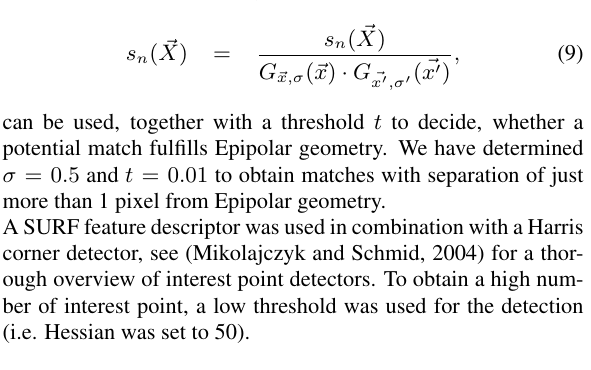
Table 1: Reconstruction Statistics for Different Camera Sys- tems: The table lists the results of reconstruction. Errors of > 100 mm were considered false matches. Displayed are me- dian errors (mm), which gives a good indication of the overall performance. Numbers are accumulated over different